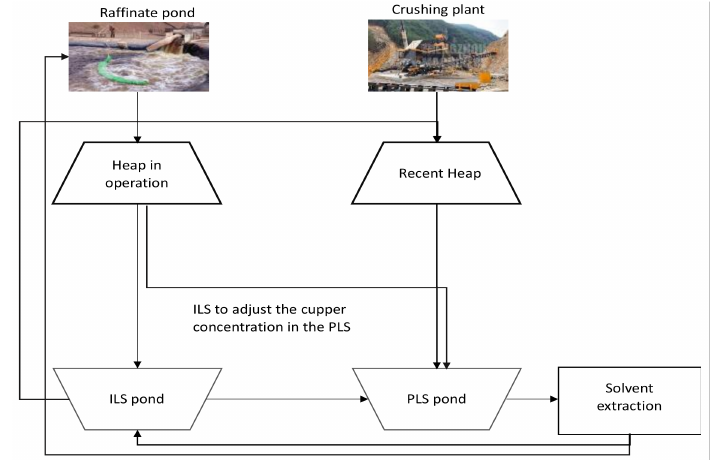
Figure 1. Main steps in the leaching